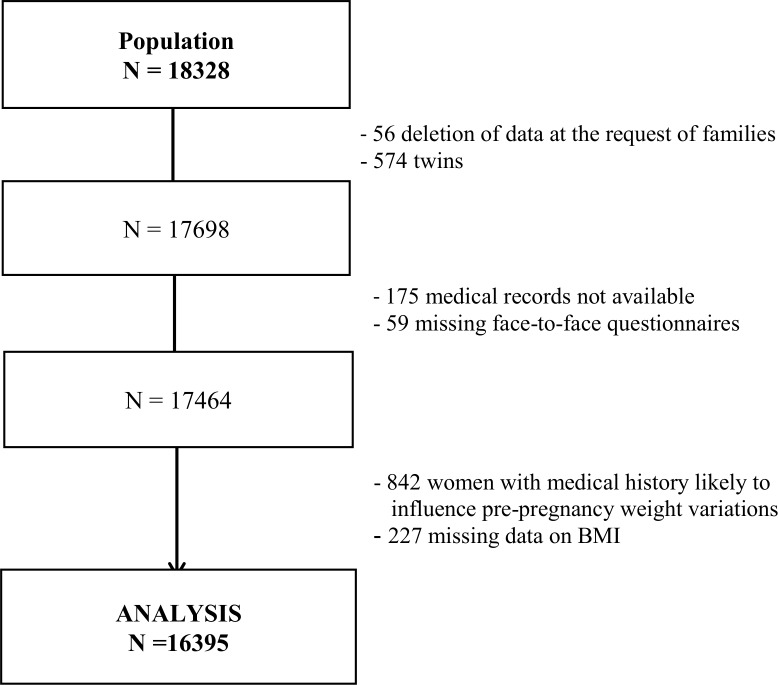
Selection of women for analysis.